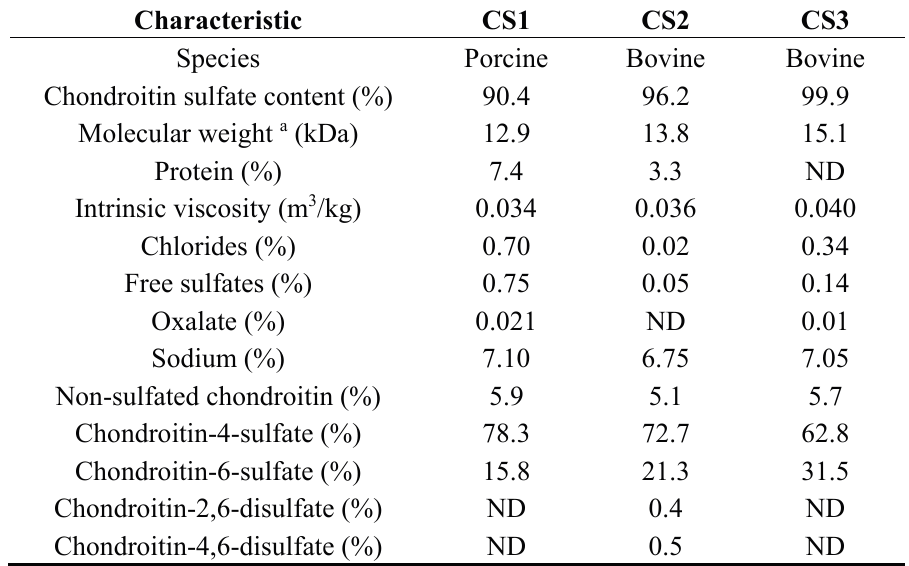
a : Indicates average molecular weight. CS, chondroitin sulfate; ND, not